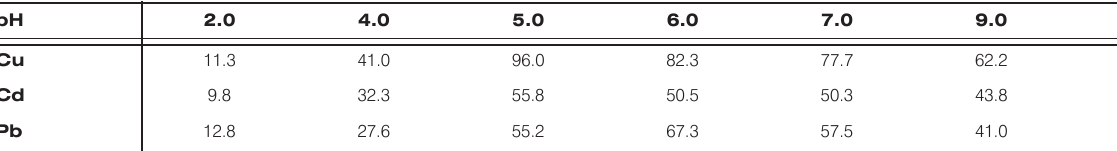
Table 1. Sorption percentage of heavy metal ions (Cu, Cd, Pb) with the sorbent studied for pH in the range 2.0-9.0 at room temperature.